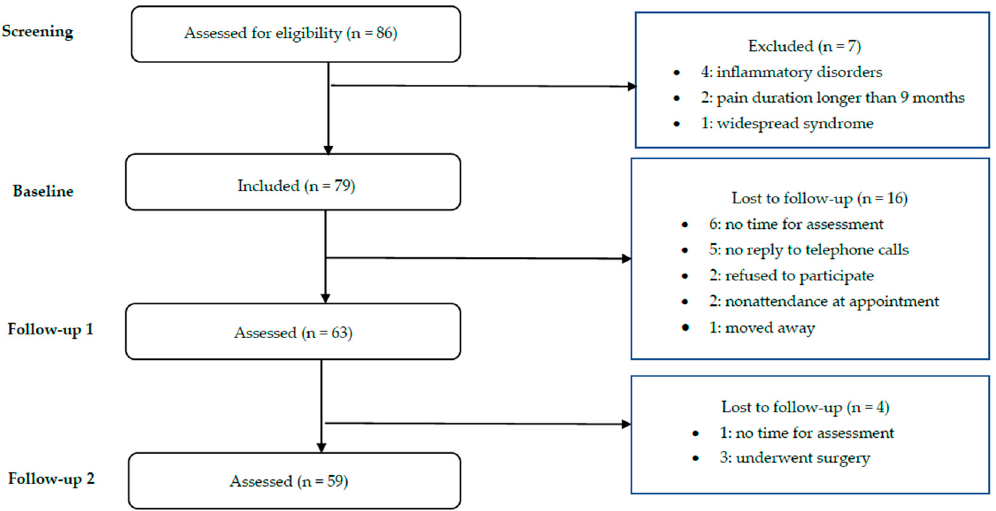
Figure 1. Flow chart of inclusion.